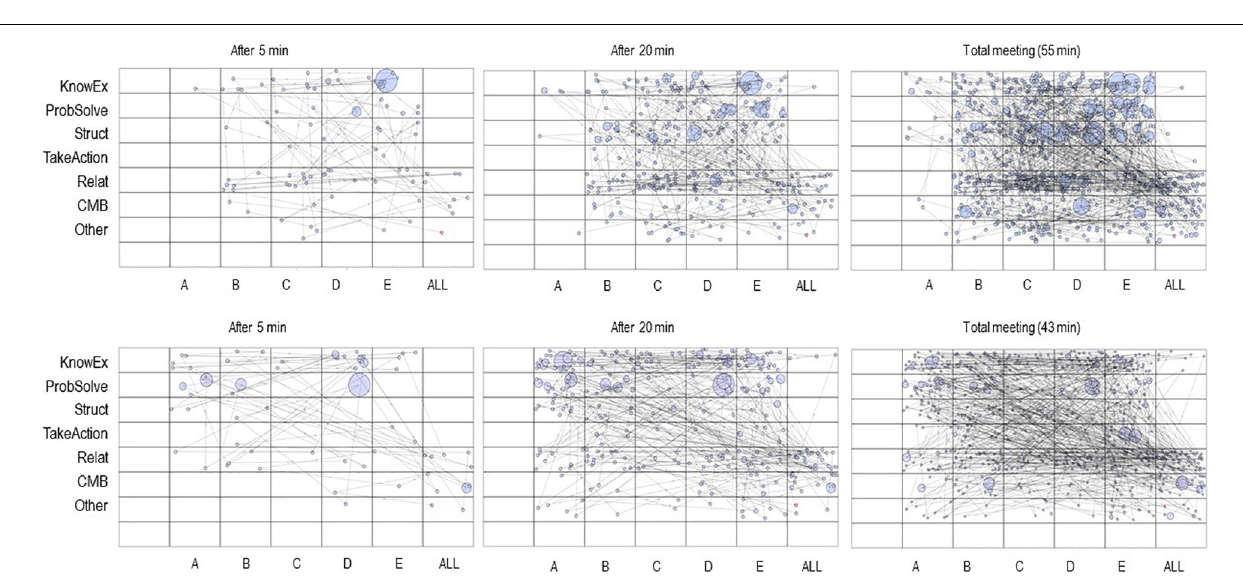
FIGURE 2 | State space grids (SSGs) representing verbal team interactions for a productive and an unproductive team at three time points for the first meeting. The (top) three panels show the SSGs of the productive team. The (bottom) three panels show the SSGs of the unproductive team. A, B, C, D, and E label each of the five team members per team. The size of the circles denotes the duration of each event. KnowEx, knowledge exchange; ProbSolve, problem solving; Struct, structuring; TakeAction, taking initiative; Relat, relational; CMB, counterproductive meeting behavior; Other, verbal behaviors that do not fit any of the six functional